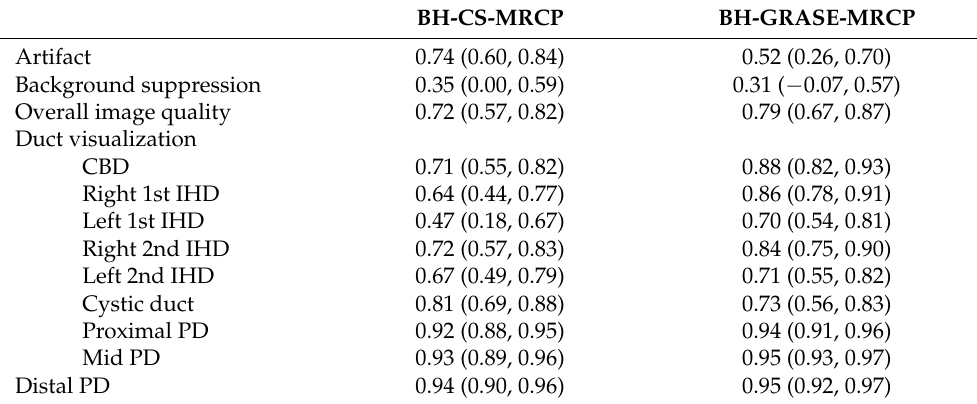
Table 3. Intraclass correlation coefficients of qualitative analysis on BH-CS-MRCP and BH-GRASE-MRCP.